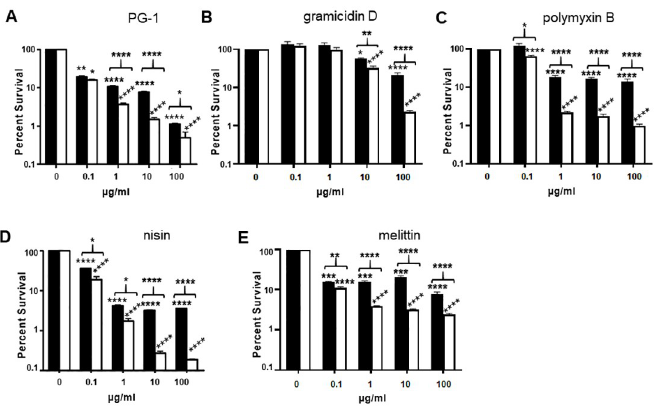
Fig 3. Various non-human cationic AMPs have reduced bactericidal activity against an encapsulated B . anthracis strain compared to a non-encapsulated strain. Encapsulated WT and non-encapsulated capA mutant bacilli were incubated with PG-1 (A), gramicidin D (B), polymyxin B (C), nisin (D), or melittin (E) in triplicate tubes at 0.1– 100 μ g/ml at 37˚C in 5% CO 2 for 2 h and plated for CFU. Survival percentages were determined by calculating the ratio of CFU with/CFU without AMP. Three experiments were run (n = 3). Results expressed as the mean + SEM from a representative experiment are shown. Black bars represent WT and white bars represent capA mutant. Significance of killing was determined by ANOVA with Tukey’s post-hoc test. Significance of differences in survival between the WT and capA strains was determined by two-tailed Student’s t-test ( � p < 0.05, �� p < 0.01, ��� p < 0.001, ���� p <